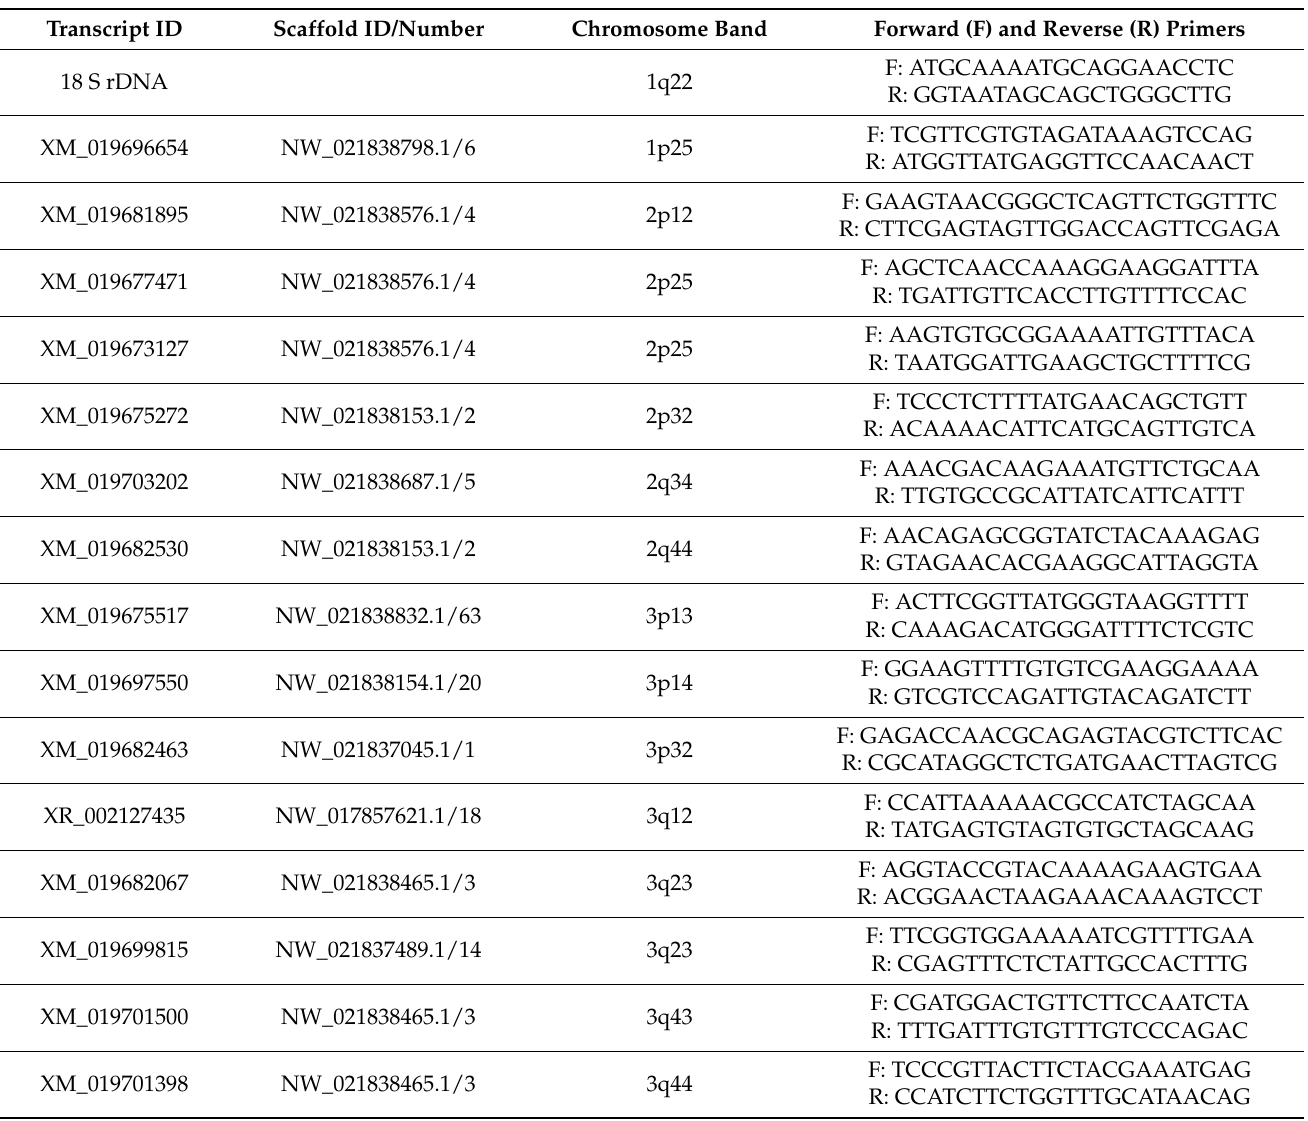
Table 1. Transcript locations in the Aedes albopictus genome assembly and chromosome map. Probes used for fluorescence in situ hybridization (FISH) are shown by transcript and gene IDs. Probe locations are indicated by scaffold number, chromosome band in the genome, or in the